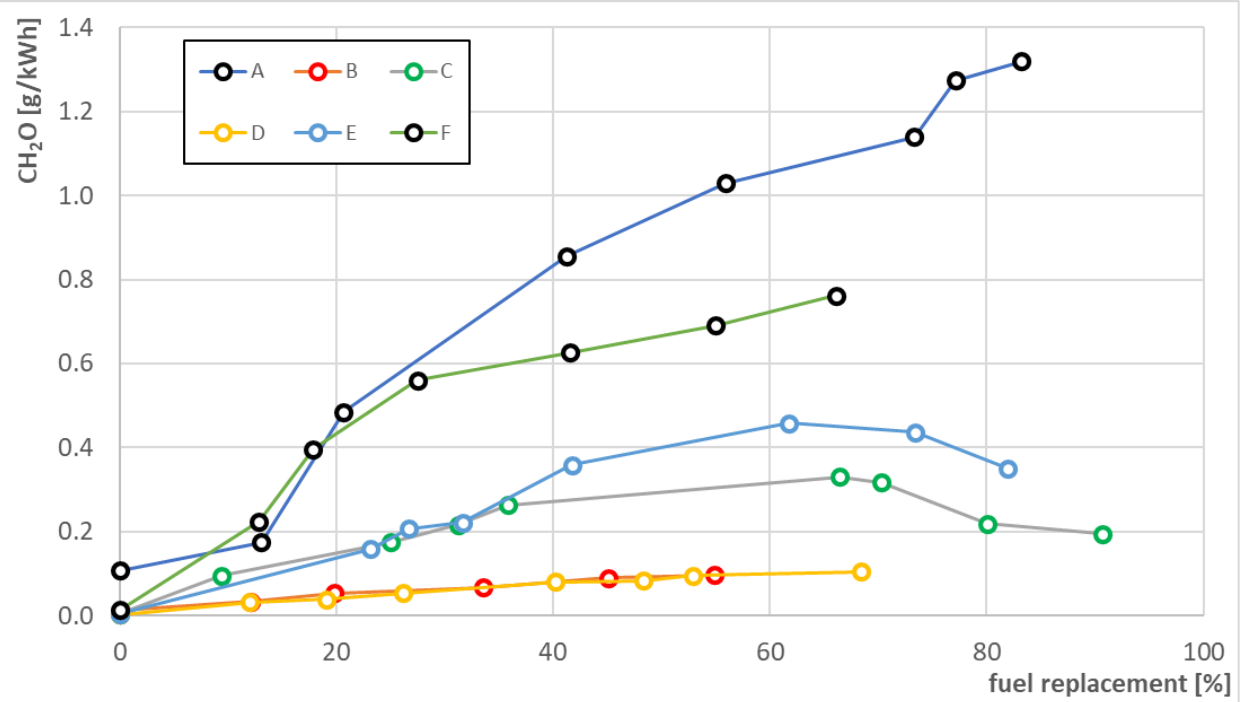
Figure 21. Curves from A to F showing engine’s emission of CH 2 O (formic formaldehyde), for individual engine operating points, where the rotation speed, power, and torque were constant, as a replacement function of diesel fuel replaced by CNG.